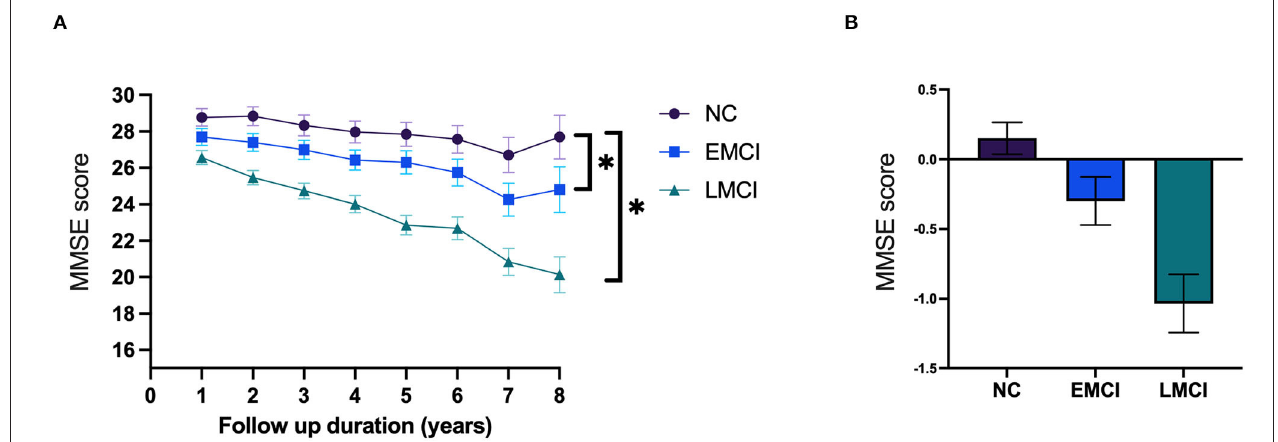
FIGURE 3 | (A) The prediction of annual changes for the mini-mental status examination (MMSE) score. (B) The annual rate of change for MMSE. NC, normal cognition; EMCI, early mild cognitive impairment; LMCI, late mild cognitive impairment. *: p <